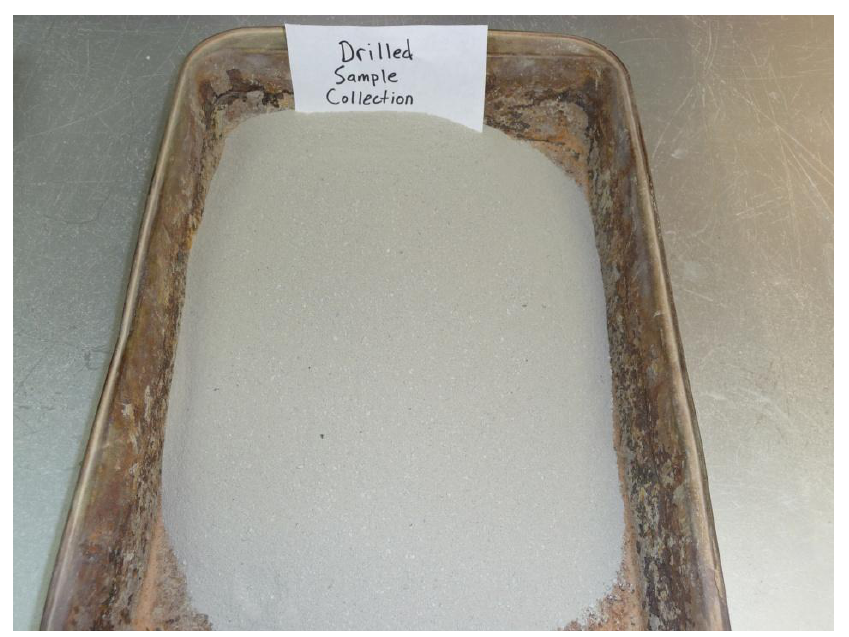
Figure 1. ( a ) Samples collected through drilling (D-samples); ( b ) Samples collected at the stockpiles